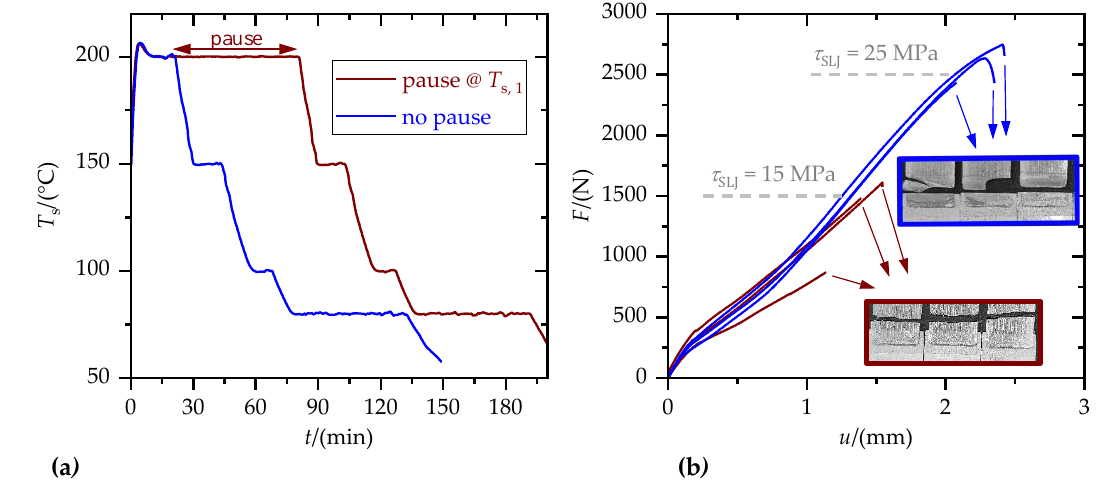
Figure 9. Influence of additional wetting time (1 h pause @ T s,1 ) on tensile single-lap-shear strength, τ SLJ . ( a ) Temperature – time profiles of the actual temperature of the substrate, T s , during ME of the SLJ; ( b ) Corresponding force – displacement diagrams, F ( u ), and SLJ fracture surfaces.